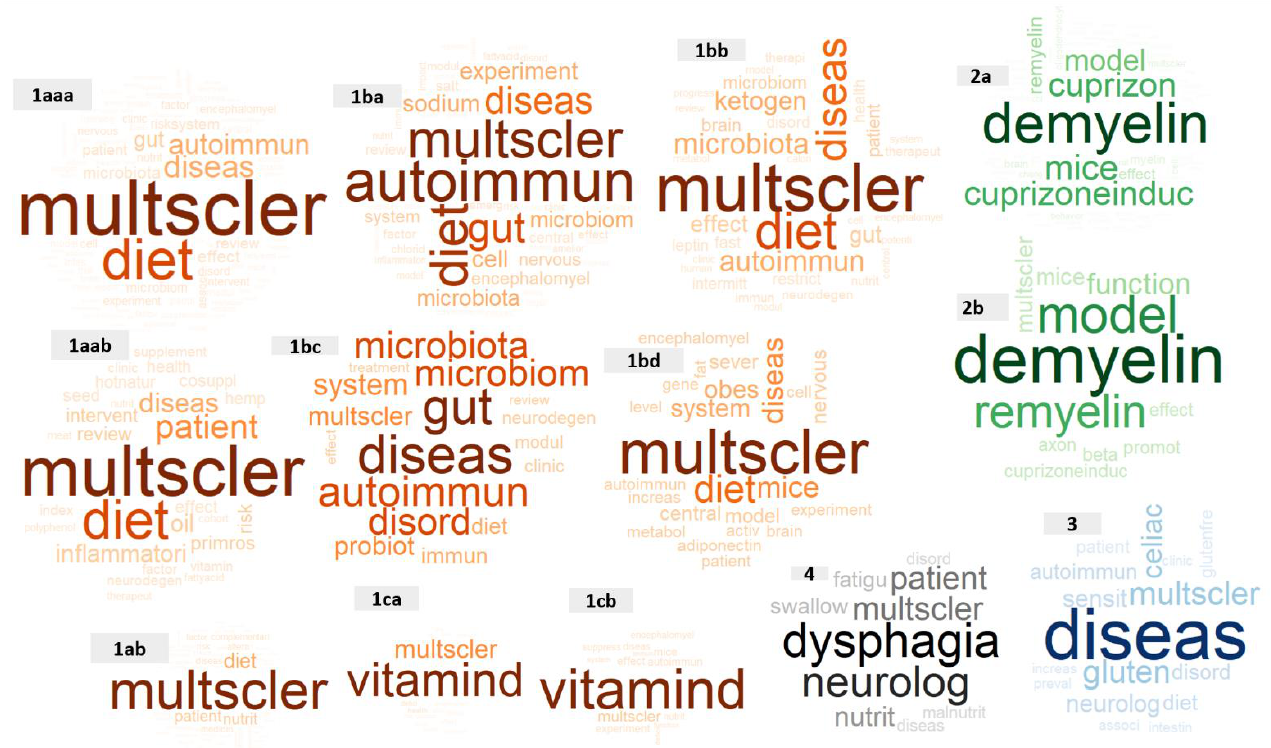
Figure 2. Word clouds of all lowest level clusters and sub-clusters. These lowest level clusters and sub-clusters are those that could not be further divided, including sub-clusters 1aaa, 1aab, 1ab, 1ba, 1bb, 1bc, 1bd, 1ca, 1cb, 2a, 2b, cluster 3 and cluster 4. The larger and more opaque words are those that appeared more frequently in the titles of articles in each sub-cluster. Orange, sub-clusters of cluster 1; green, sub-clusters of cluster 2; blue, cluster 3; and grey, cluster 4. Note: The word size does not represent the frequency of words proportionally across sub-clusters.